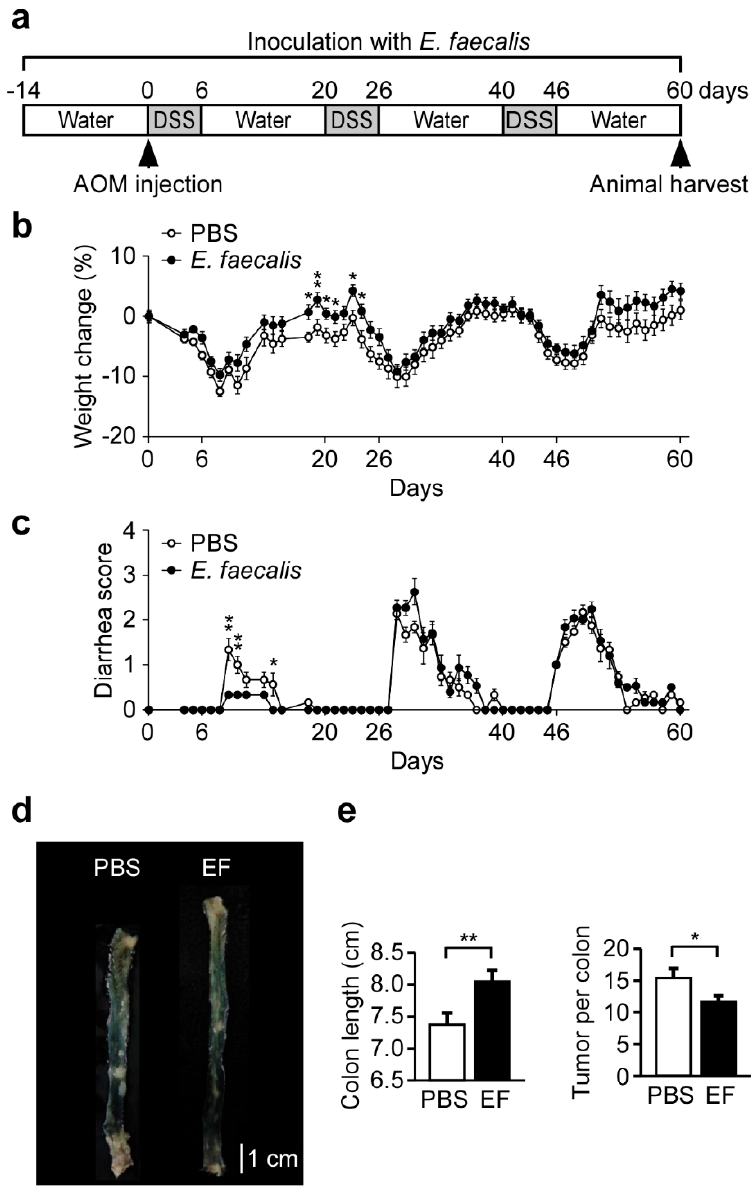
Figure 5. E. faecalis pretreatment protects mice from colitis-associated CRC. ( a ) Schematic presentation of the mouse model of colitis-associated CRC. Mice were orally inoculated with E. faecalis every day during the course of experiment, starting two weeks before the adminutesistration of DSS. Mice were injected intraperitoneally with AOM prior to beginning the first of three cycles of DSS in the drinking water. One cycle was defined as 6 days of DSS followed by 14 days of water. 60 days after the start of DSS treatment, all mice were sacrificed; n = 14 mice for the PBS control and E. faecalis -treated groups. ( b , c ) Percent weight change ( b ) and diarrhea scores ( c ) were monitored daily in all mice. ( d ) Representative images of colons. ( e ) Colon length and tumor number. Scale bars, 1 cm. *, p < 0.05; and **, p <